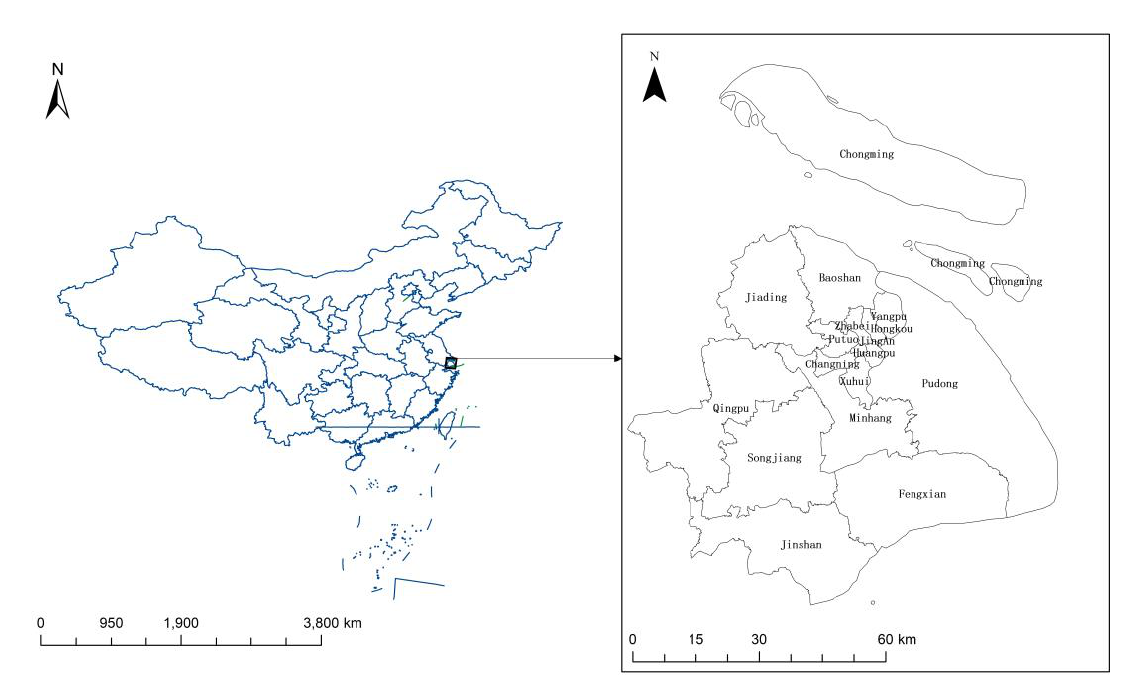
Figure 1. Location of Figure 1 . Location of Shanghai.